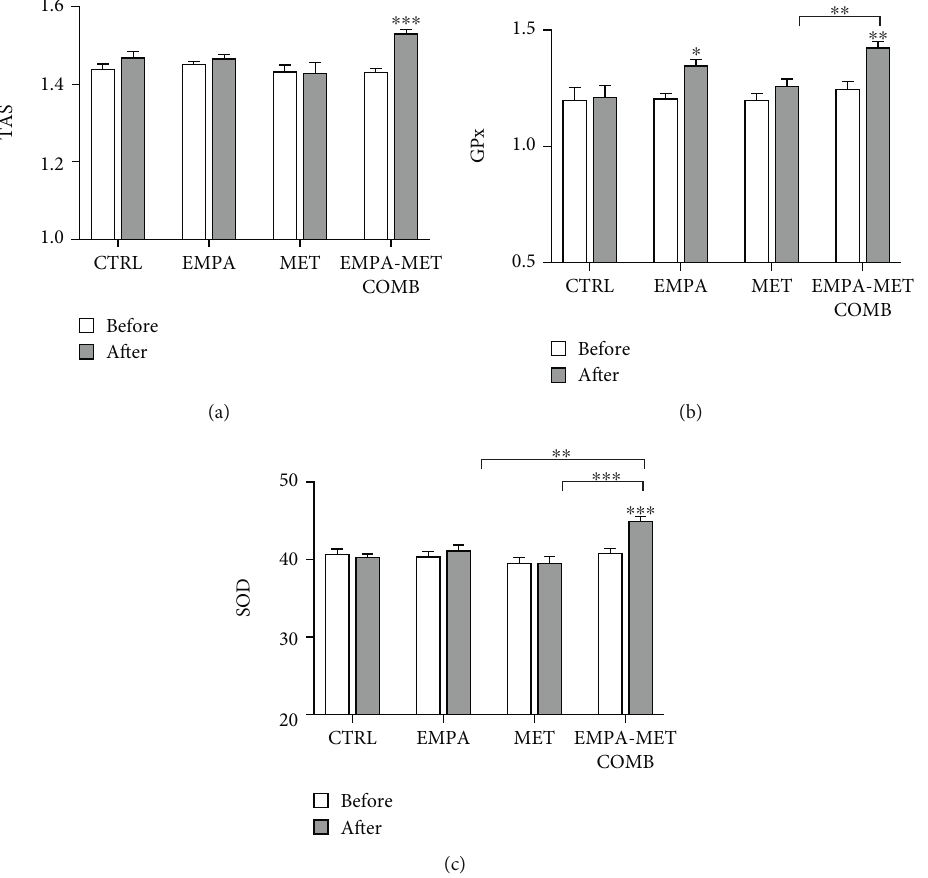
Figure 1: Levels of serum antioxidants in individuals with type 1 diabetes, before and after treatment with empagli fl ozin 25 mg daily (EMPA), metformin 2000 mg daily (MET) or empagli fl ozin-metformin combination (EMPA-MET COMB), or in control (CTRL): (a) total antioxidative status (TAS), (b) glutathione peroxidase (GPx), and (c) superoxide dismutase (SOD). ∗ represents P < 0 : 05 ; ∗∗ represents P < 0 : 01 , and ∗∗∗ represents P < 0 : 001